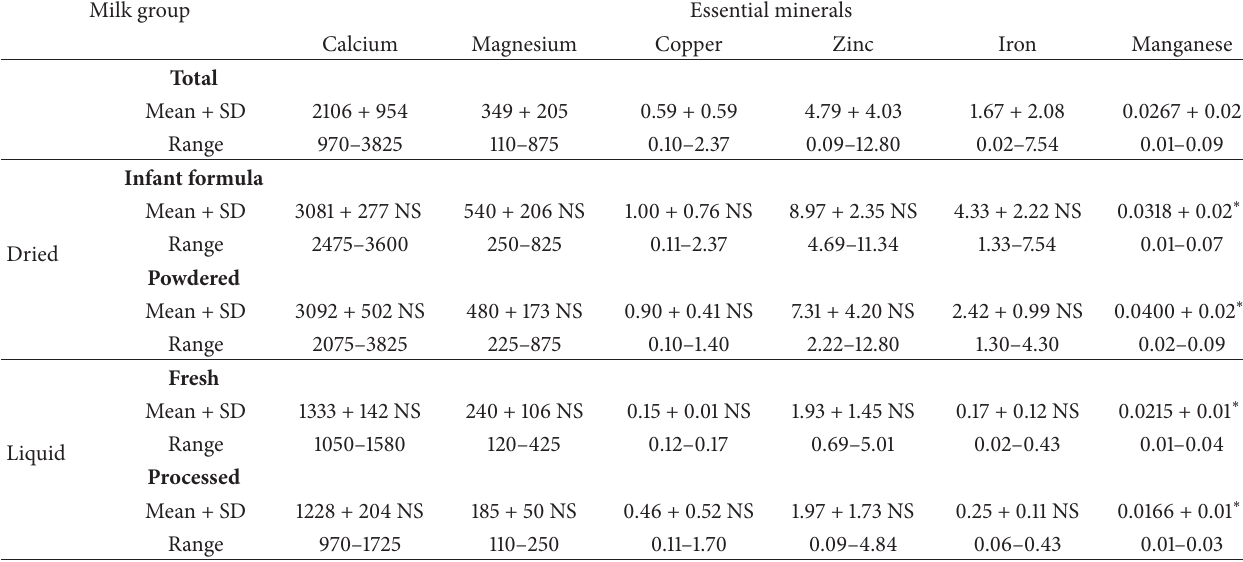
Table 1: Concentration of essential mineral elements (ppm) in milk.